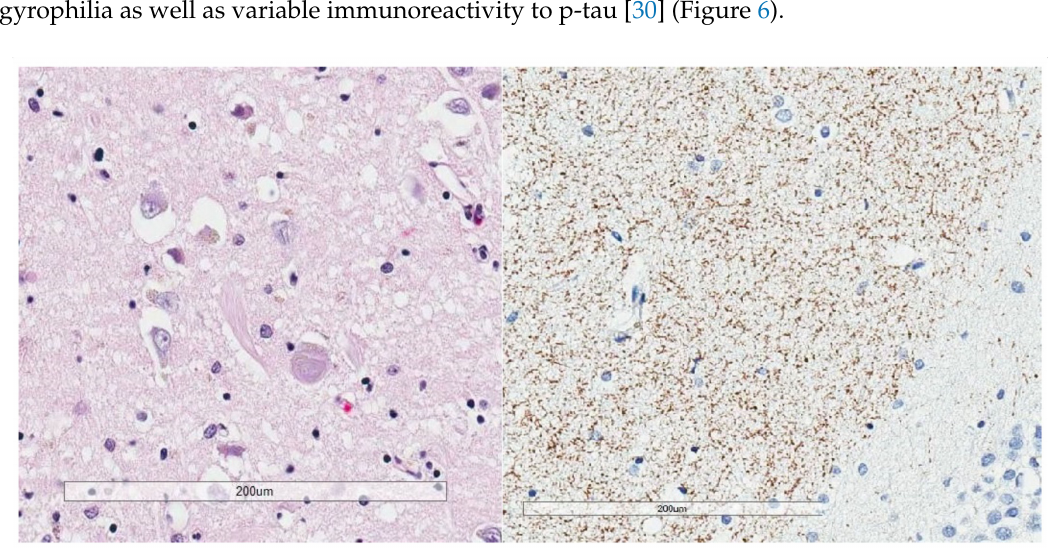
Figure 6. The kinetics of p-tau labeling over time is generally unclear because autopsy examination is a single snapshot in time. Extracellular or “ghost” neurofibrillary tangles ( left ) are evidence that neurofibrillary tangles are resistant to degradation, with some studies suggesting that they persist in brain tissue for decades. On the other hand, dendritic labeling by p-tau immunohistochemistry in the stratum lacunosum moleculare ( right ) may be